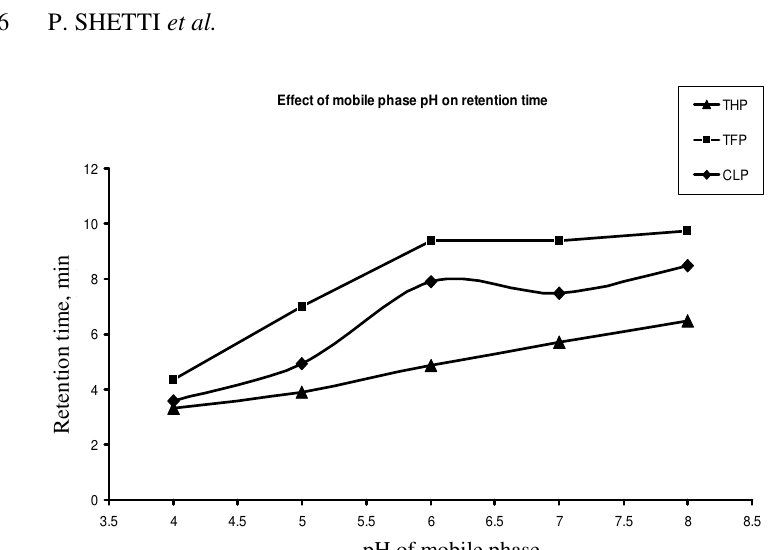
Figure 3. Effect of mobile phase pH on retention time of THP, TFP and CLP keeping mobile phase proportion constant as Ammonium acetate buffer (1% w/v): methanol (15:85)